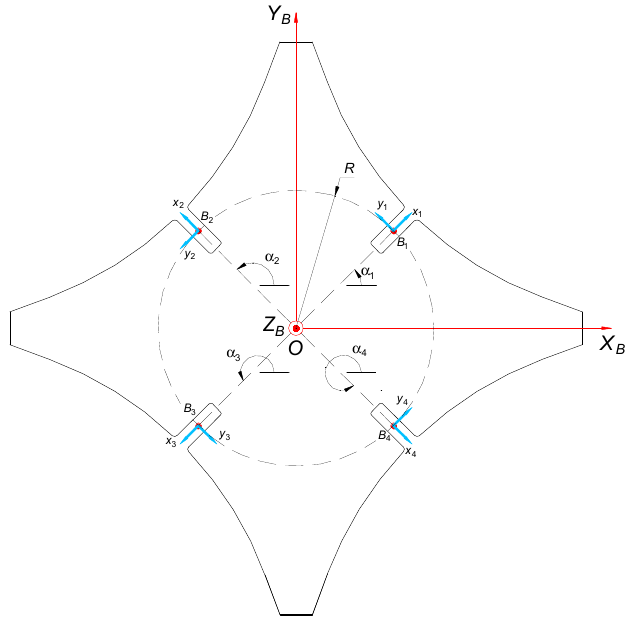
Figure 4. Overview of the immoveable manipulator basis with indicated characteristic geometrical points.